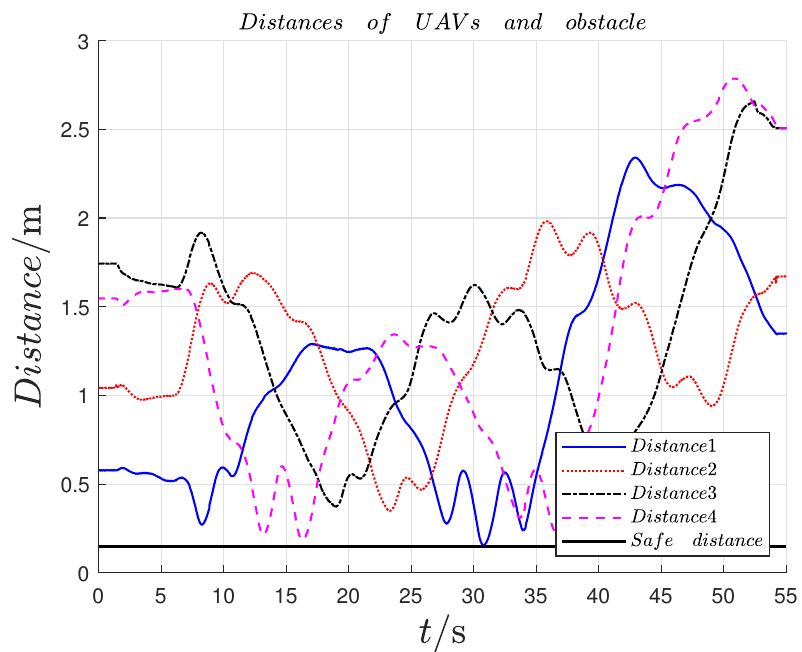
Figure 14. Relative distance of Tello and